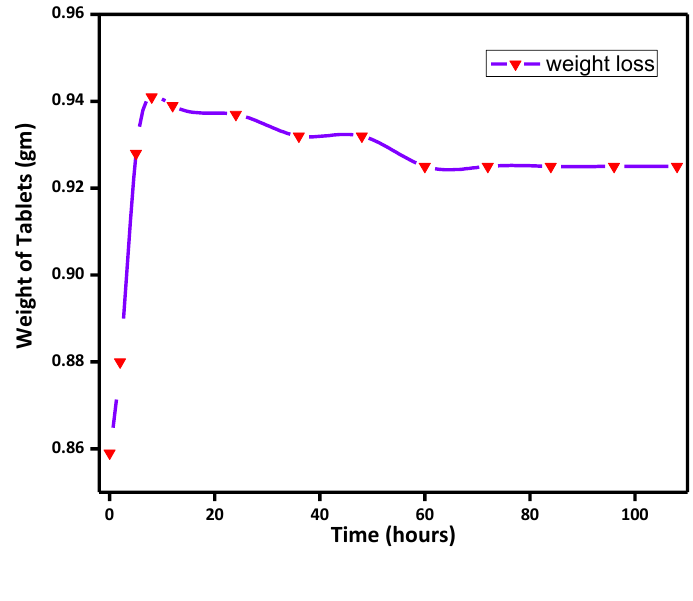
Figure 8. Weight loss study of the BG